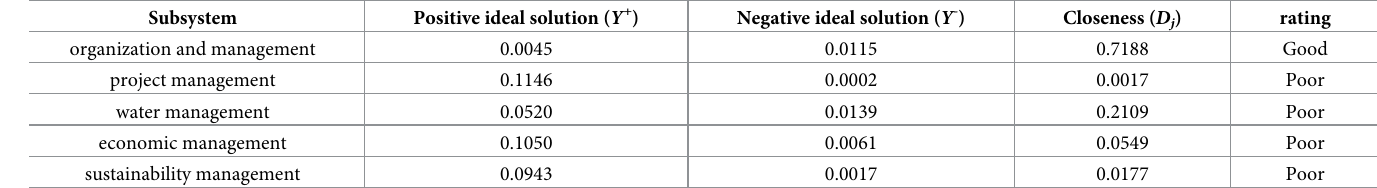
Table 6. Euclidean spatial distance between each subsystem and the ideal solution under the joint-stock management mode.